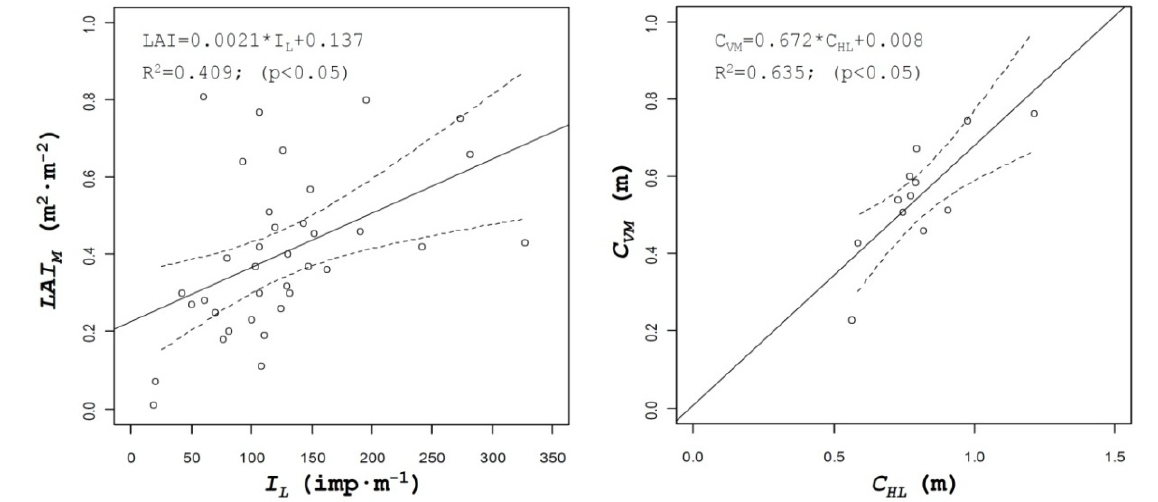
Table 2. Coefficients of determination (R 2 ) among crop parameter values obtained with the three measurement systems.